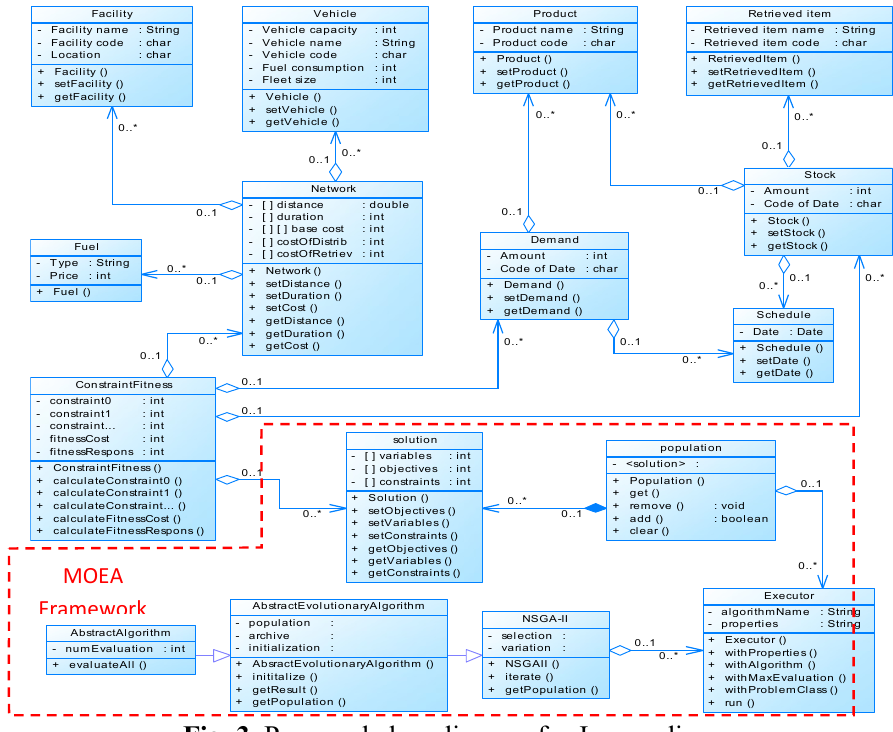
Fig. 3. Proposed class diagram for Java